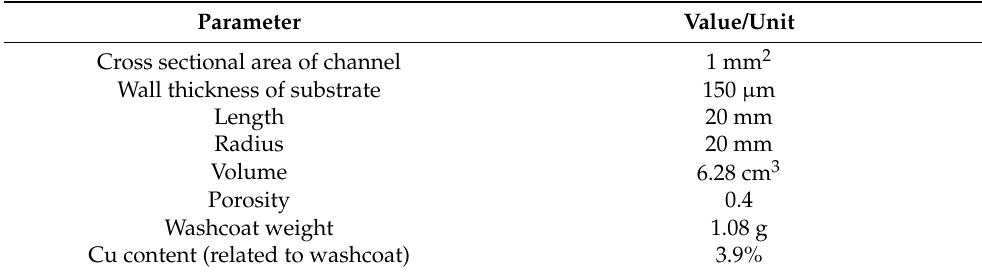
Table 3. Structural physical parameters of Cu-CHA honeycomb cordierite ceramic